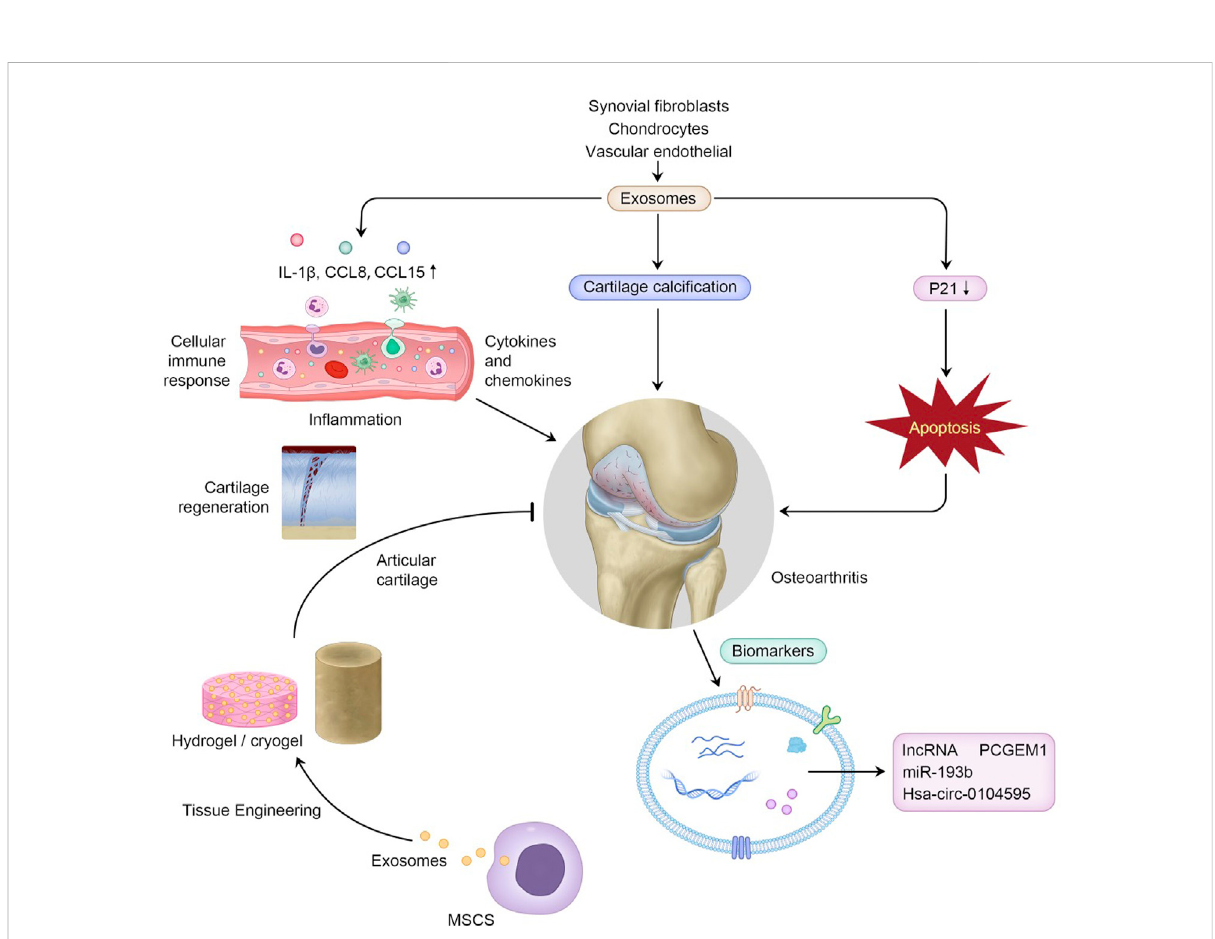
FIGURE 1 Exosomes in OA pathogenesis, and their clinical potential to serve as biomarkers in the diagnosis of OA and to function in cartilage tissue engineering combined with biomaterials.